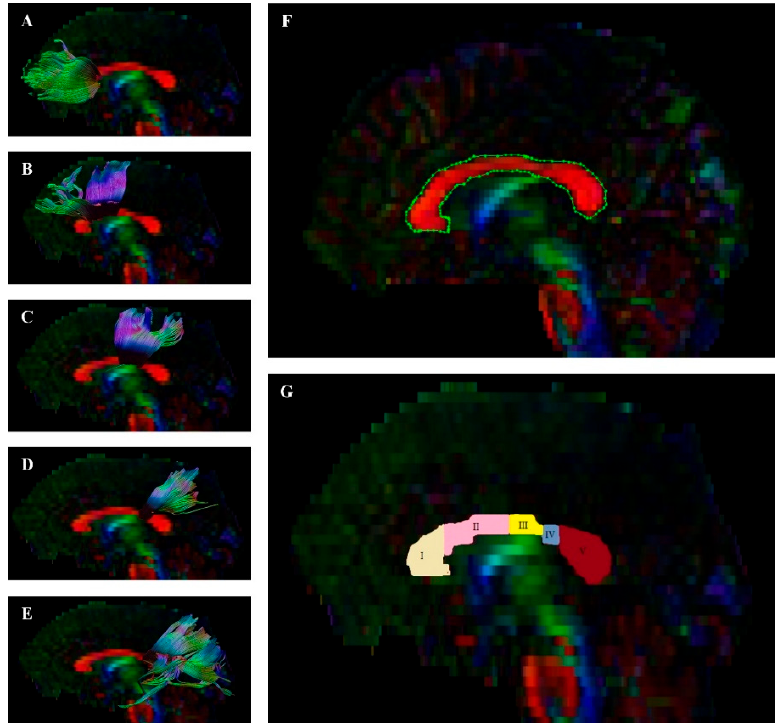
Figure 1. Diffusion tensor tractography of the corpus callosum (CC) with fractional anisotropy color maps (mid-sagittal plane). Green, red, and blue colors represent fibers running along the axis (anterior-posterior, left-right, and superior-inferior, respectively). Five single projections with ROIs on a sagittal plane (( A ) = Region 1, ( B ) = Region 2, ( C ) = Region 3, ( D ) = Region 4, ( E ) = Region 5), ( F ) = whole region of CC, and ( G ) = all regions of CC (based on Hofer and Frahm’s [16] segmentation: I = Region 1, II = Region 2, III = Region 3, IV = Region 4, V = Region 5). The methodology and segmentation scheme are discussed in our previous publication [80].